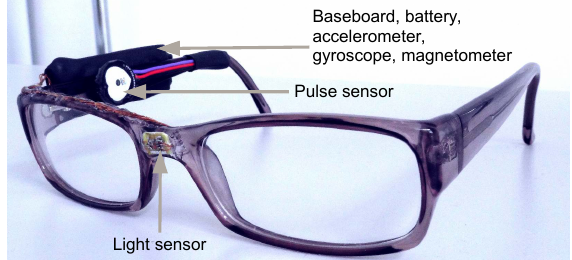
Figure 1: WISEglass prototype. Baseboard, bat- tery, accelerometer, gyroscope, and magnetometer were mounted on the outside of a eyeglasses tem- ple. The pulse sensor was mounted on the inside of a temple. The light sensor was integrated onto the